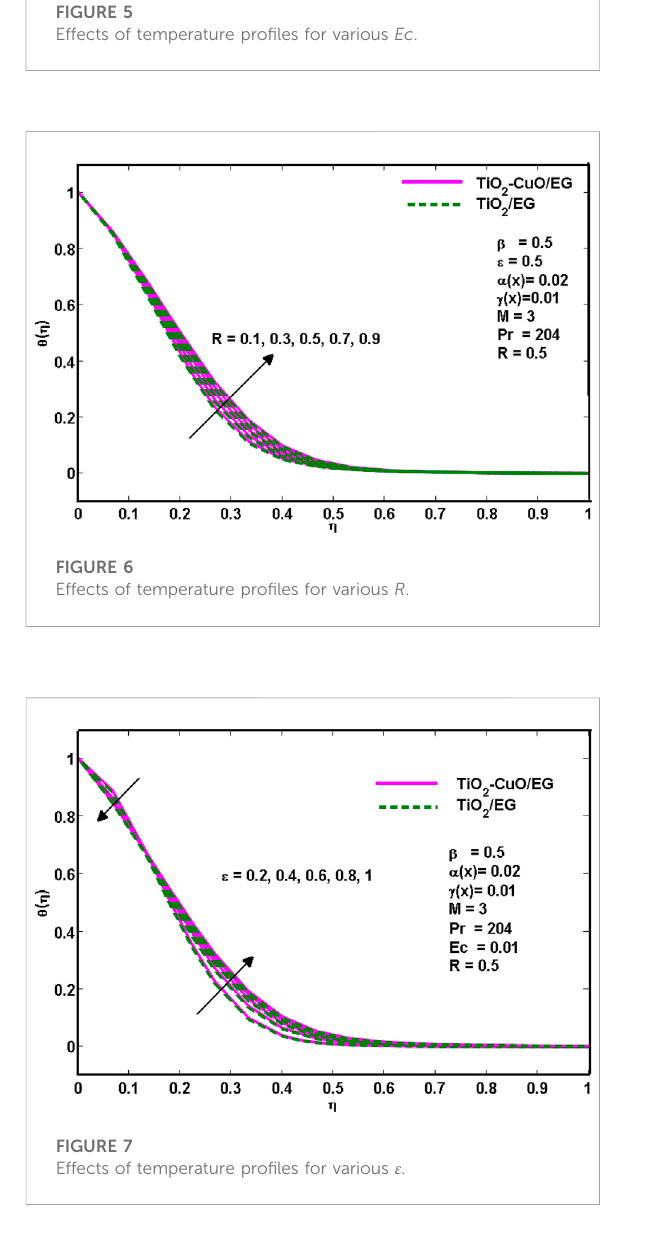
FIGURE 8 Effects of skin friction for certain ε and β .